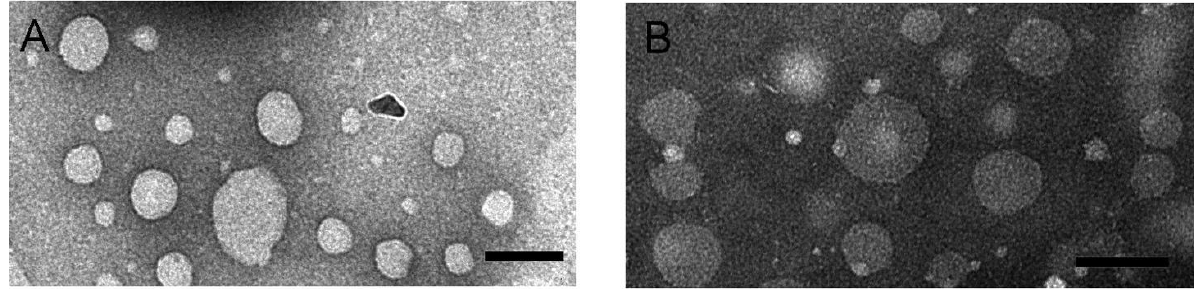
Figure 2. TEM images obtained by PTA staining of RIF-loaded HSPC–DPPG liposomes dissolved in Hepes buffer ( A ) and in THP culture medium ( B ). Bar represents 100 nm.